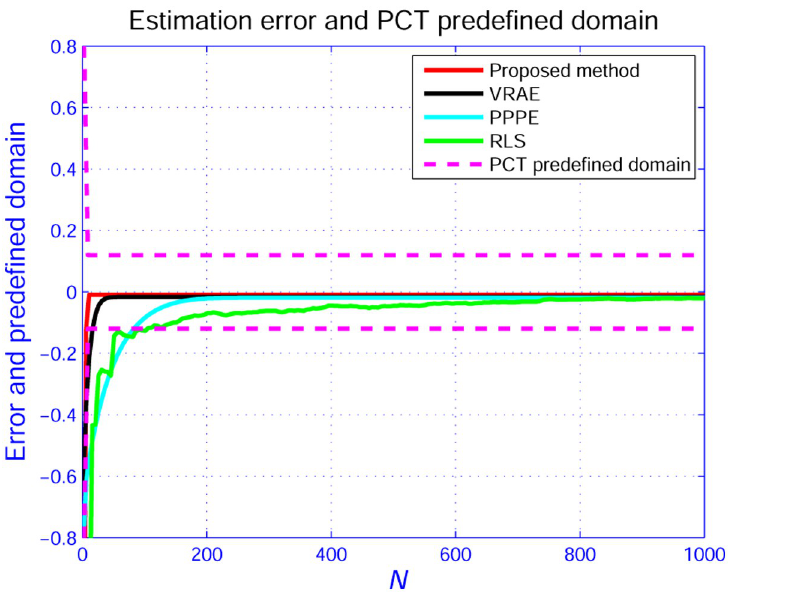
Fig 8. Estimation error